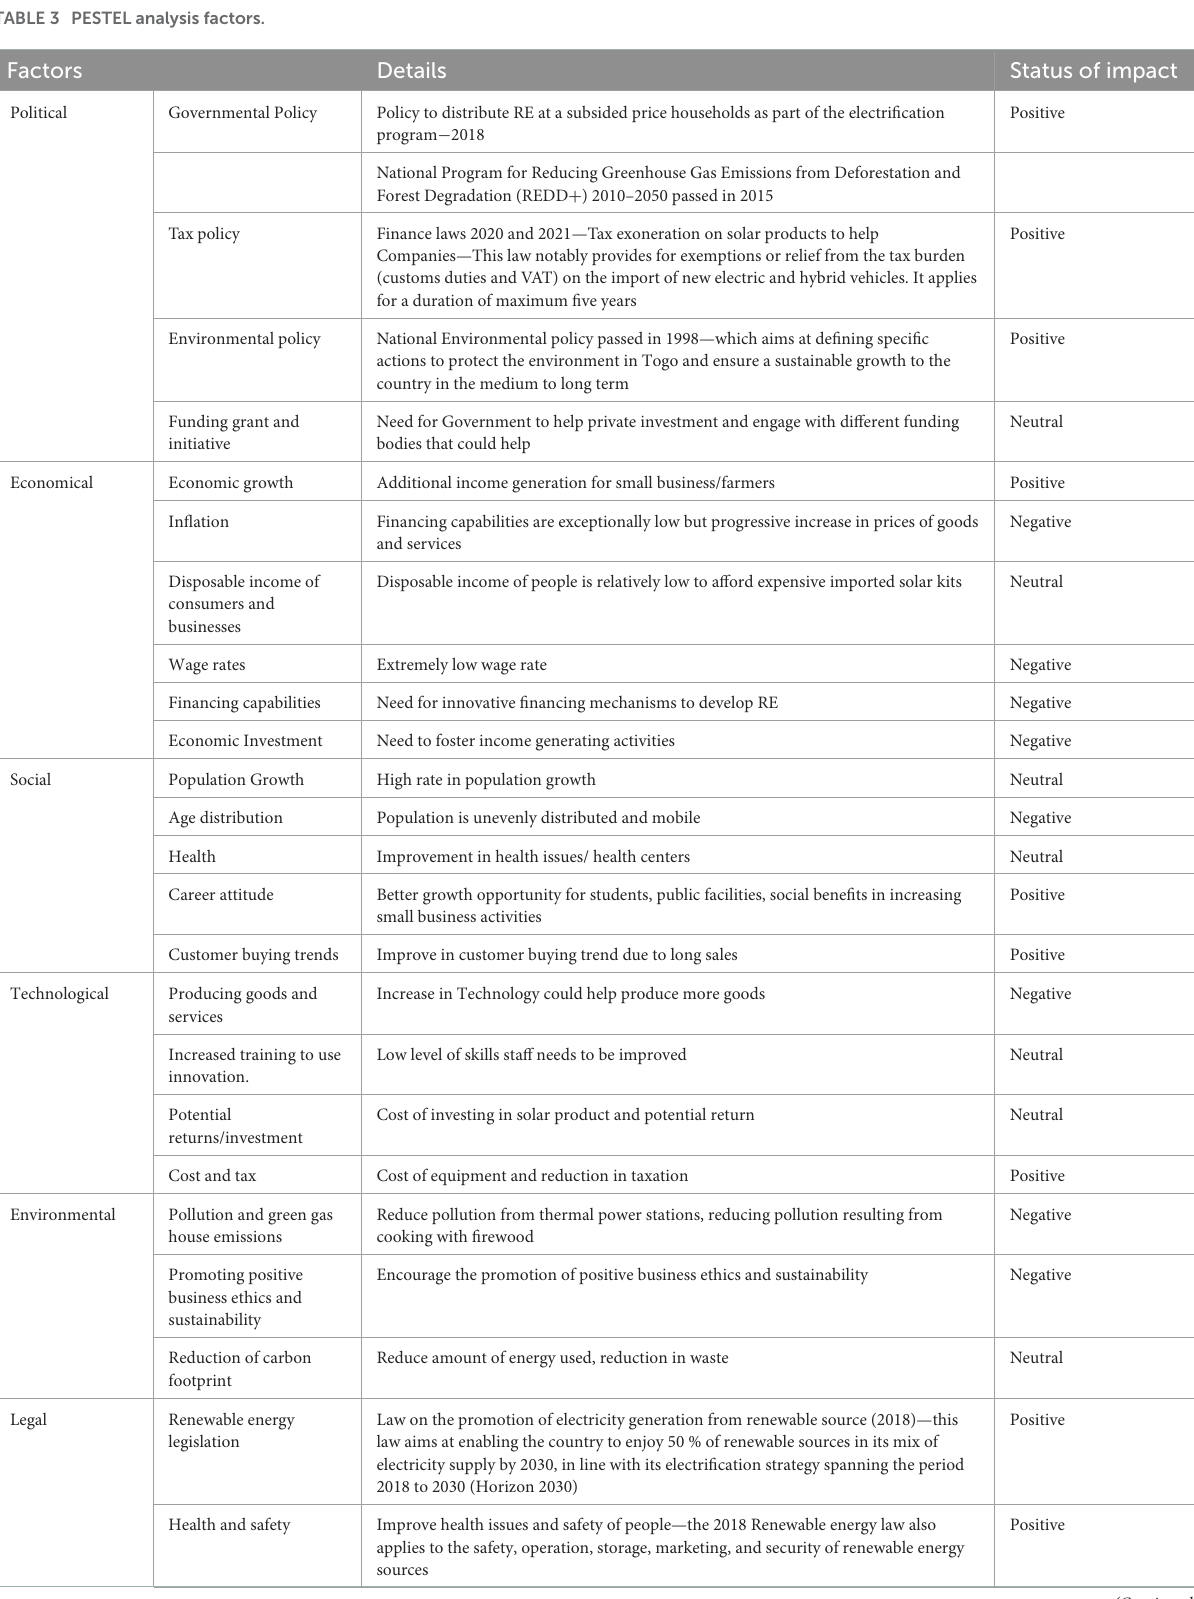
TABLE 3 PESTEL analysis